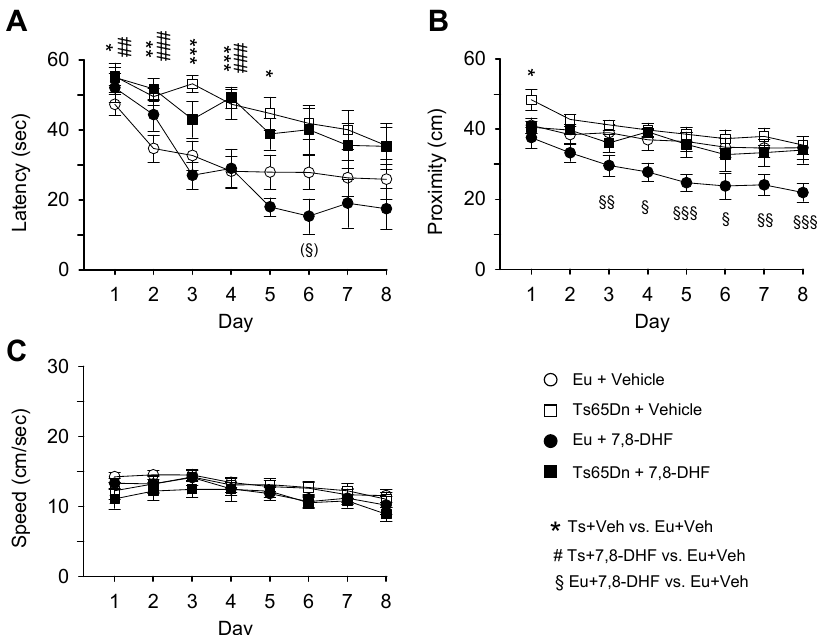
Figure 4. E ff ect of treatment with 7,8-DHF on spatial learning in adult mice. Euploid and Ts65Dn mice aged 4 months received one injection of vehicle or 7,8-DHF for 39 days and were subjected to the MWM starting from the 30th day of treatment. Spatial learning was assessed with MWM in untreated euploid mice ( n = 13), untreated Ts65Dn mice ( n = 11), treated euploid mice ( n = 7), and treated Ts65Dn mice ( n = 7). The curves in A-C report data of euploid mice that received either vehicle (empty circle) or 7,8-DHF (filled circle) and Ts65Dn mice that received either vehicle (empty square) or 7,8-DHF (filled square). A,B: In the learning phase of the MWM, the latency to reach the platform ( A ), proximity to the platform zone ( B ), and swimming speed ( C ) were evaluated. Values are mean ± SE. The symbol * indicates a di ff erence between untreated euploid and untreated Ts65Dn mice, the symbol # indicated a di ff erence between untreated euploid mice and treated Ts65Dn mice, and the symbol § indicates a di ff erence between treated and untreated euploid mice. One symbol in brackets: p < 0.06; one symbol: p ≤ 0.05; two symbols: p ≤ 0.01; three symbols: p ≤ 0.001 (Fisher LSD test after ANOVA). Abbreviations: 7,8-DHF, 7,8-dihydroxyflavone; cm, centimeters; Eu, euploid; sec, seconds; Ts, Ts65Dn; Veh,